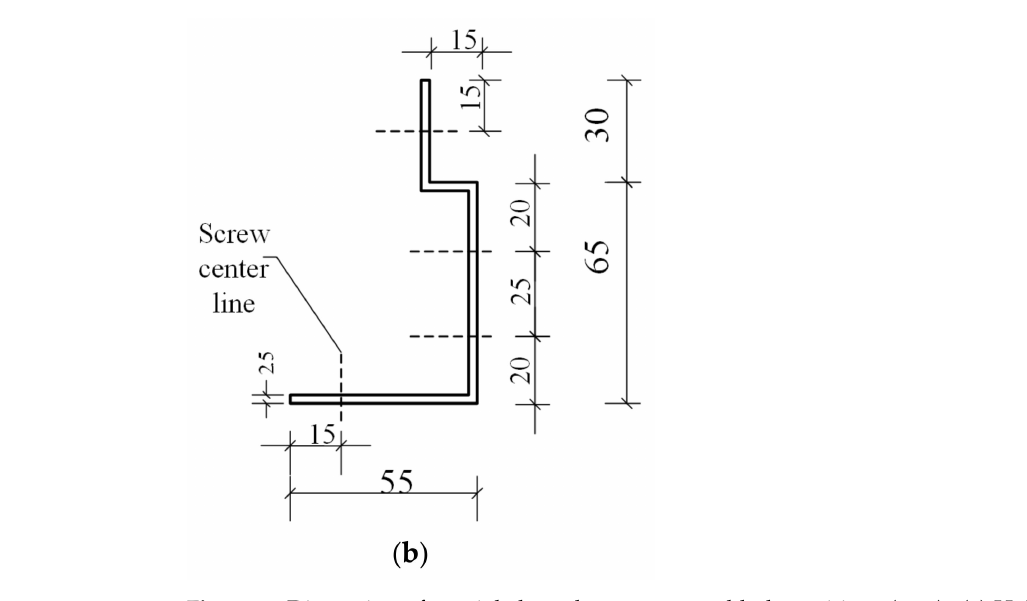
Figure 3. Dimension of special-shaped connector and hole positions (mm). ( a ) Hole positions of special-shaped connector. ( b ) Section dimension of special-shaped connector. Table 1. Test parameter